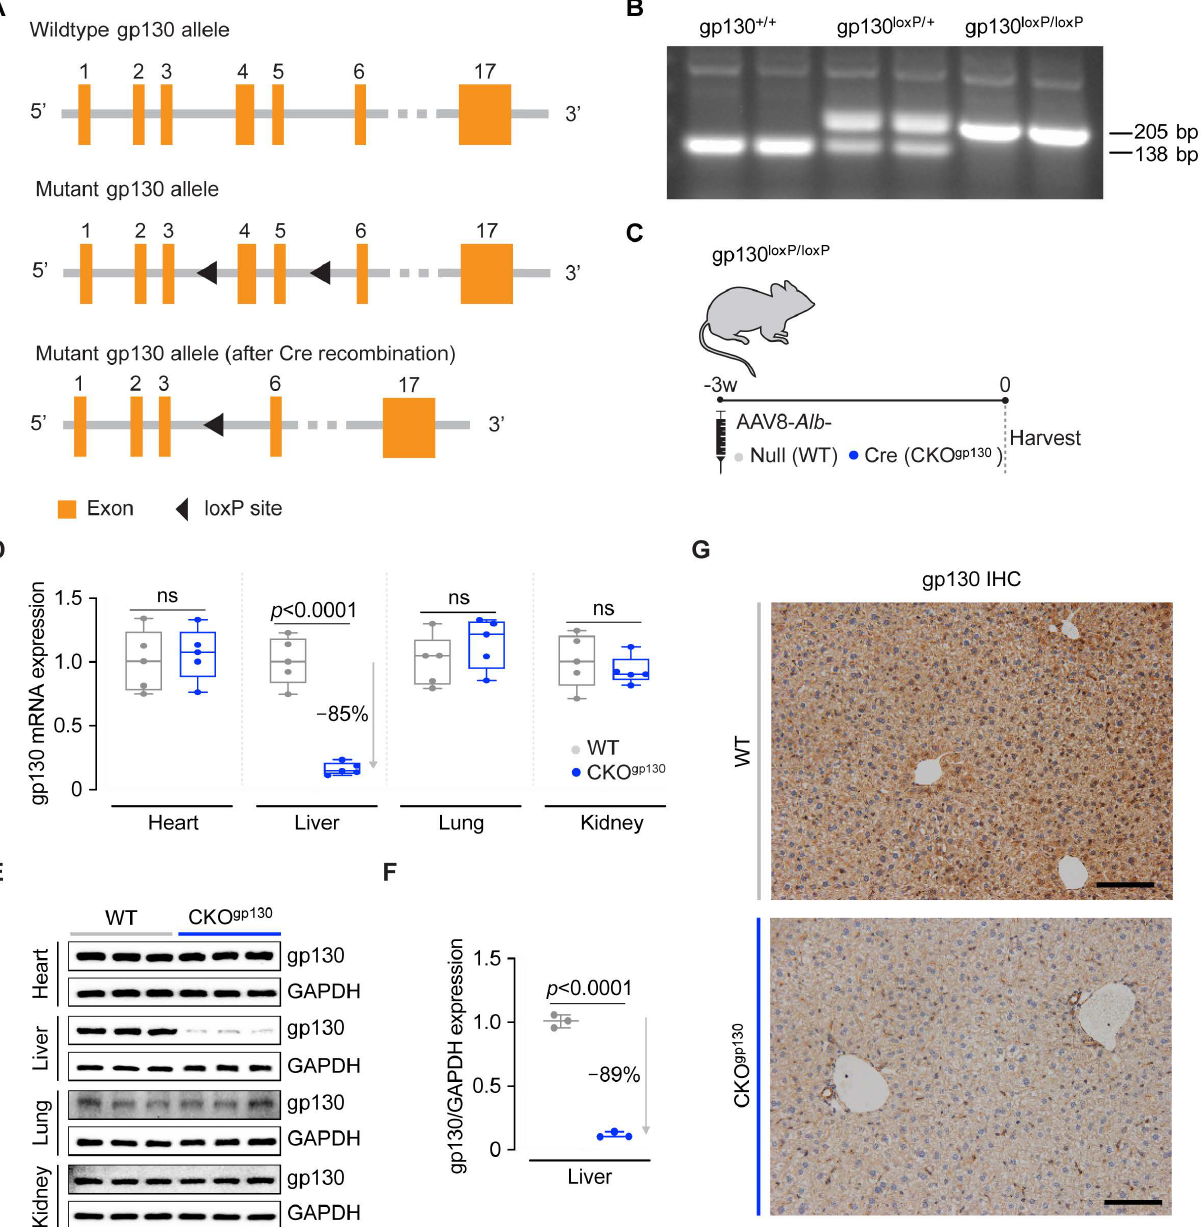
Figure 1. Generation and validation of hepatocyte-specific, gp130-deficient adult mice. ( A ) Schematic of loxP sites introduced into introns 3 and 5 of the gp130/ Il6st locus used for the generation of gp130 loxP/loxP mice. ( B ) Representative genotyping of gp130 +/+ , gp130 loxP/+ , or gp130 loxP/loxP mice. ( C ) Schematic showing AAV8-induced, hepatocyte-specific gp130 knockout mice (CKO gp130 ) for data shown in ( D – G ). ( D ) gp130 mRNA ( n = 5/group) and ( E ) gp130 protein expression ( n = 3/group) in the heart, liver, lung, and kidney. ( F ) Densitometry analysis ( n = 3/group) and ( G ) a representative IHC staining image of gp130 expression in mice liver (scale bars, 200 µ m). ( D , F ) Data are shown in a box-and-whisker plot with median (middle line), 25th–75th percentiles (box), and minimum- maximum values (whiskers); 2-tailed Student’s t